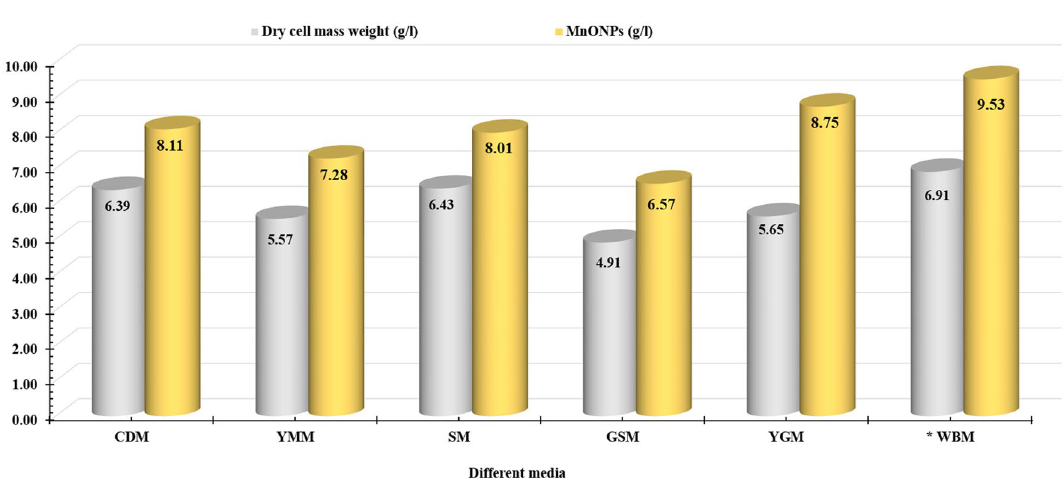
Figure 4. FTIR spectra of the extract of endophytic Trichoderma virens strain EG92 ( A ), and the fungus- fabricated MnO NPs ( B ).